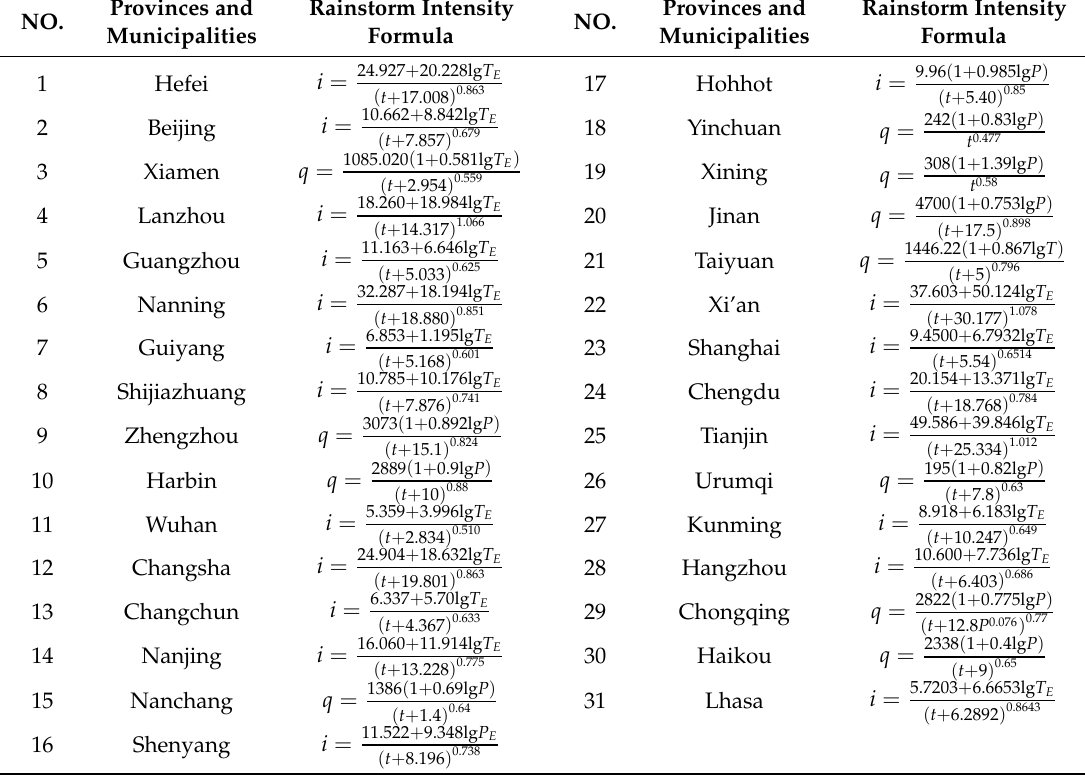
Table 1. Standard urban storm intensity formula a